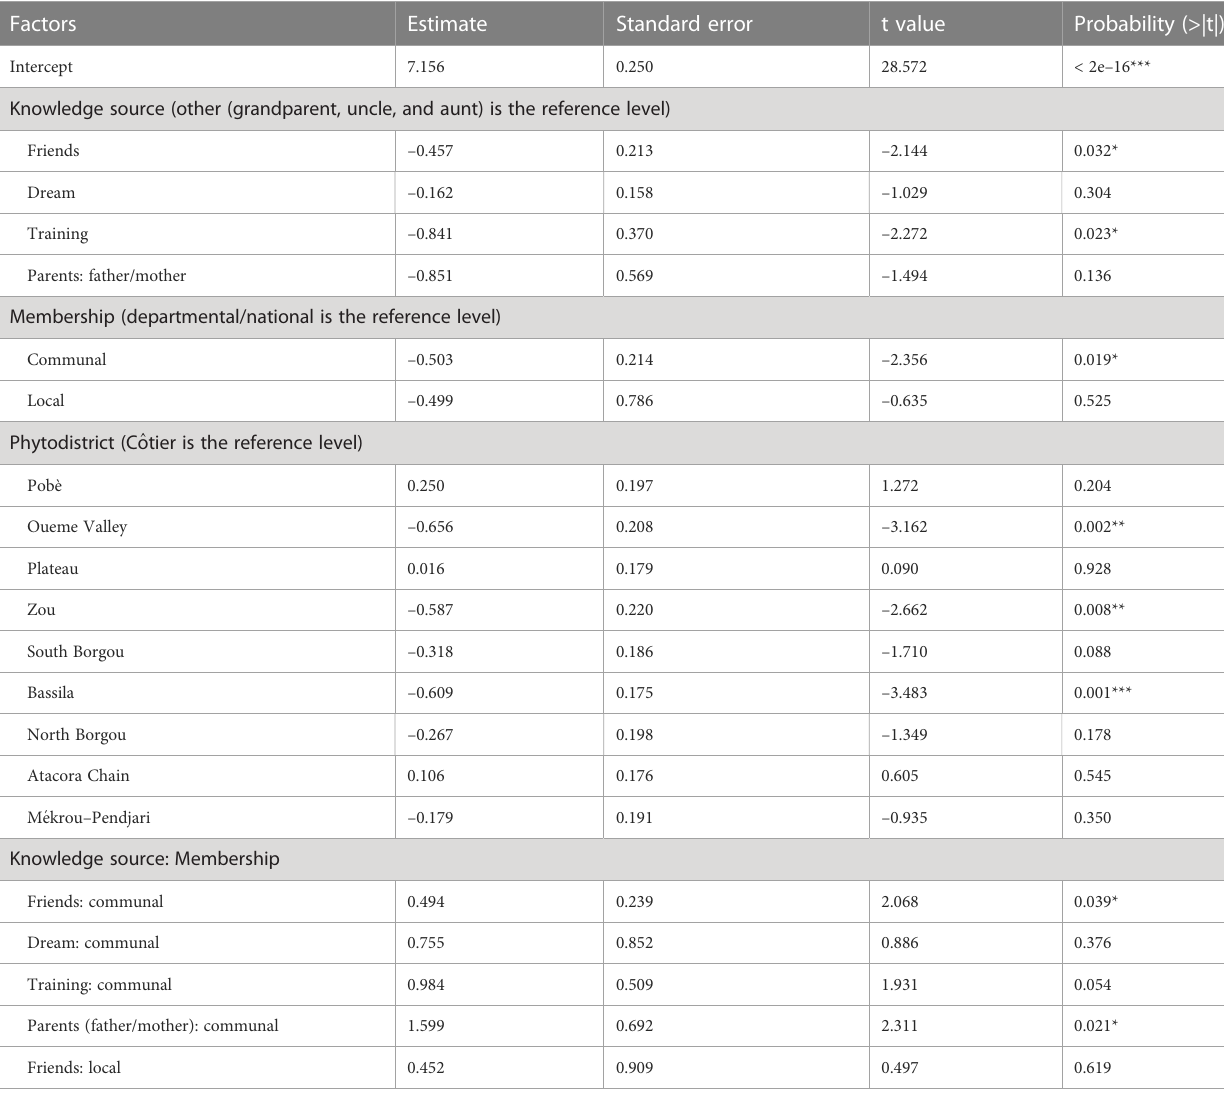
TABLE 5 General linearized model output of social, and plants ecological factors effects on the ethnomedicinal